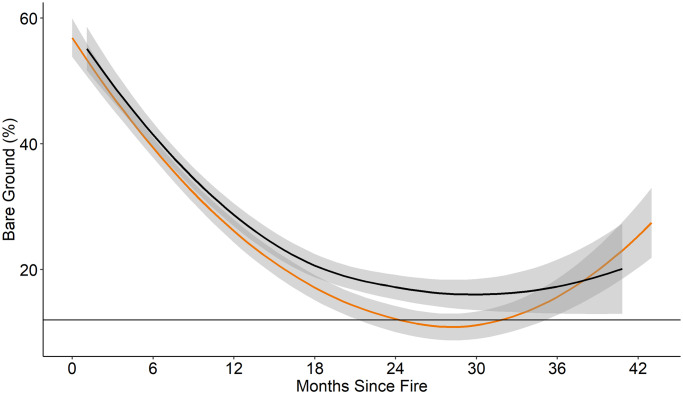
Percent bare ground.Percent bare ground for fire-only (orange) and pyric herbivory (black) treatments at all sites from 2014 to 2016. Shaded area indicates 95% confidence interval. Horizontal line represents the minimum amount of bare ground (12%) reported for areas used by prairie-chicken broods. *Regression lines and confidence intervals generated using “loess” locally-weighted smoothing function.